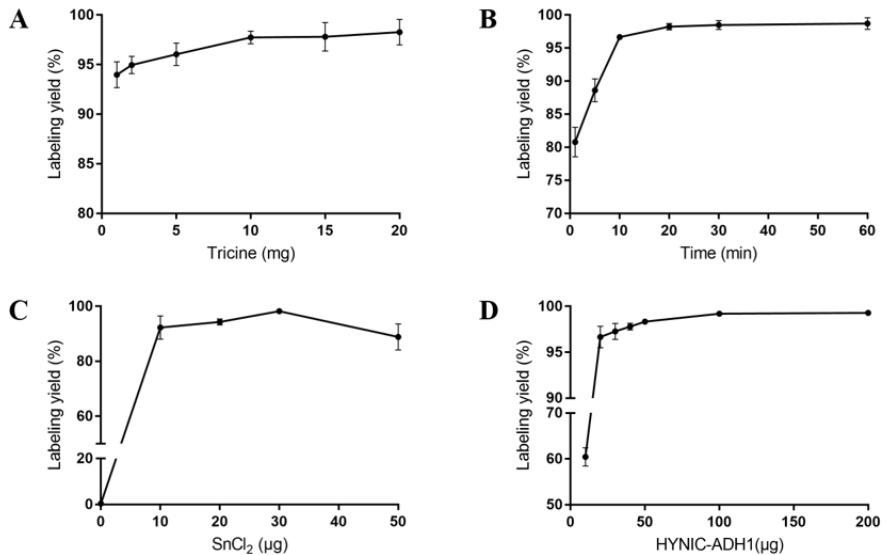
Figure 2. The optimum reaction conditions of 99m Tc labeled HYNIC-ADH-1. ( A ) The effect of reaction time on labeling yield (%). ( B ) The effect of tricine dosage on labeling yield (%). ( C ) The effect of SnCl 2 dosage on labeling yield (%). ( D ) The effect of HYNIC-ADH-1 dosage on labeling yield (%). All data are expressed as mean ± SD ( n = 4).